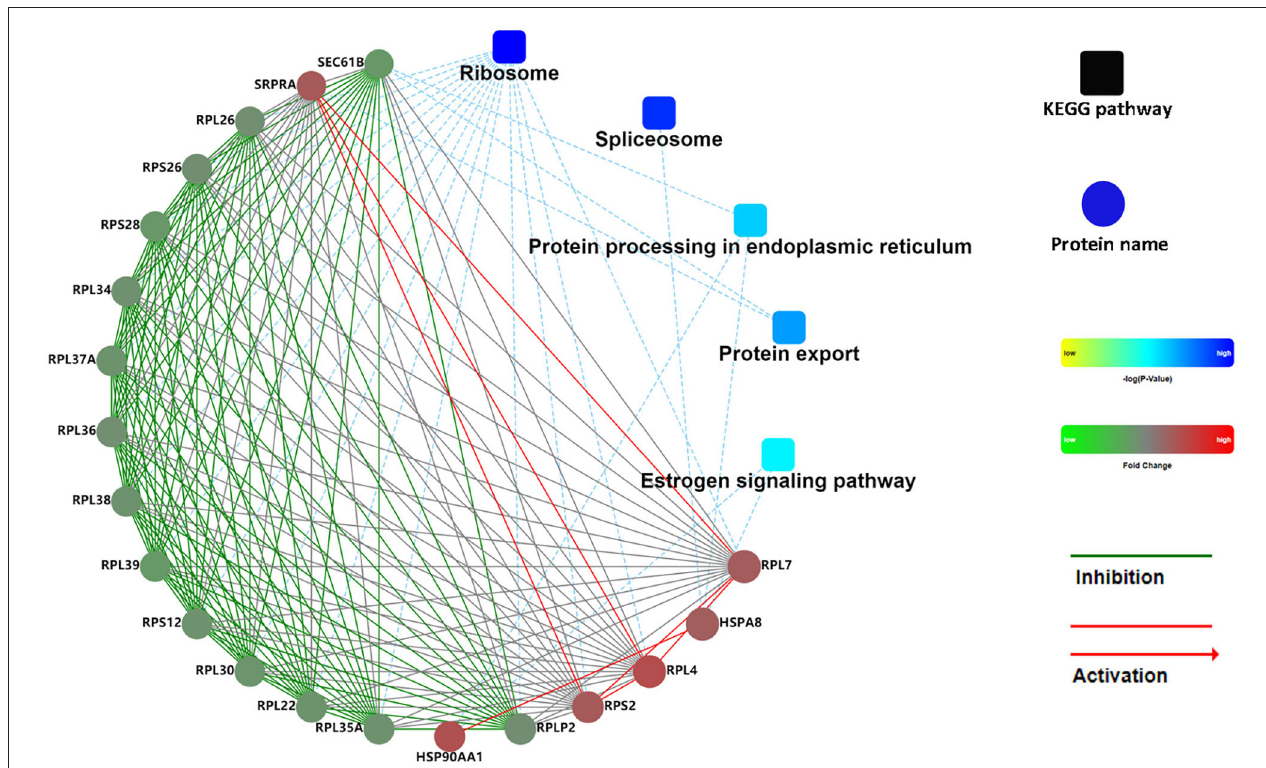
FIGURE 7 | PPI network of DAPs in FD-LSC-1 cells. Coloration with gradient: from yellow (lower p -value) to blue (higher p -value). The proteins with different abundances are indicated in red (upregulation in the AGL group) and green (downregulation in the AGL group). The default confidence cutoff value was fixed at 400. The red solid lines represent activation. The blue dashed lines indicate the KEGG pathway. PPI, protein-protein interaction; DAPs, differentially abundant